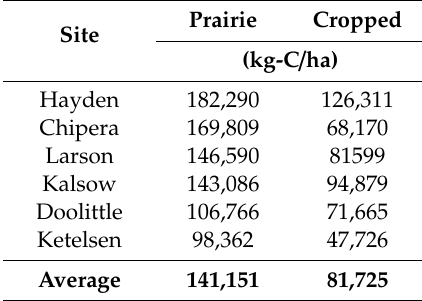
Table 1. Comparison of soil organic C levels (0–15 cm) in adjacent native prairie remnants and long-term cultivated fields in Iowa. Paired soils sampling sites were selected within 20 m of each other and within the same soil map unit. Soils were sampled an analyzed using methods described in Russell et al.